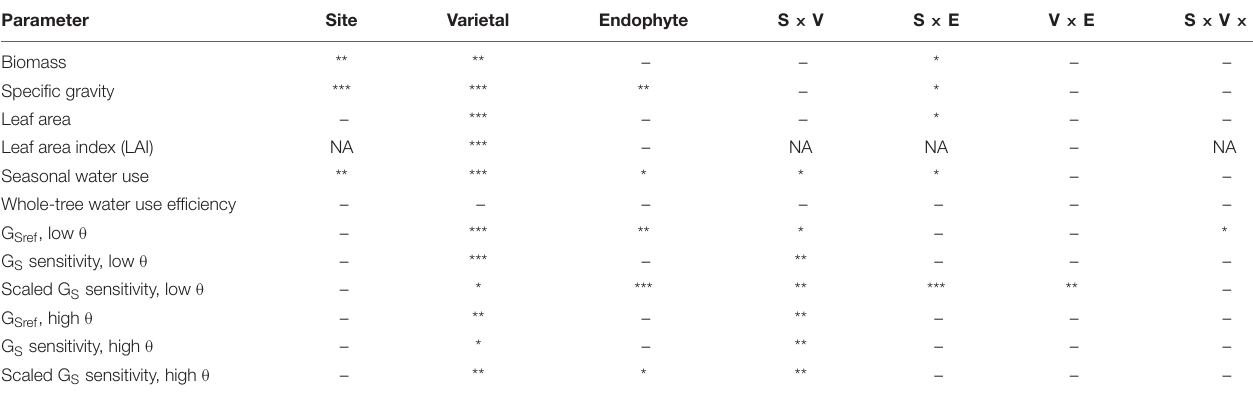
Scaled G S sensitivity, high θ